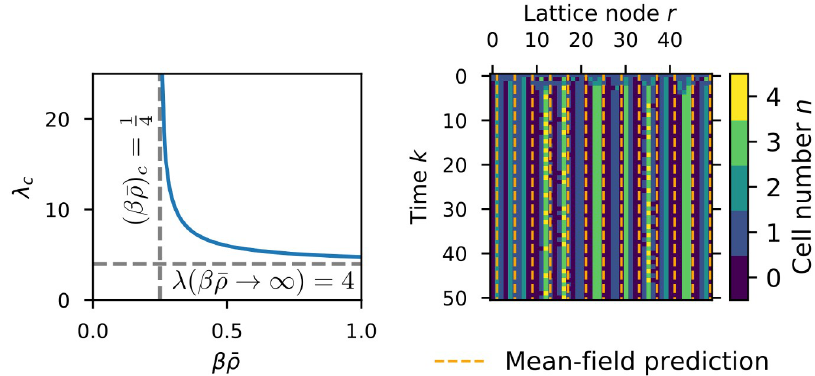
¼ 1 = 4 , and lim l ¼ 4 . Right: emergence of a ð b � r Þ c !1 c c